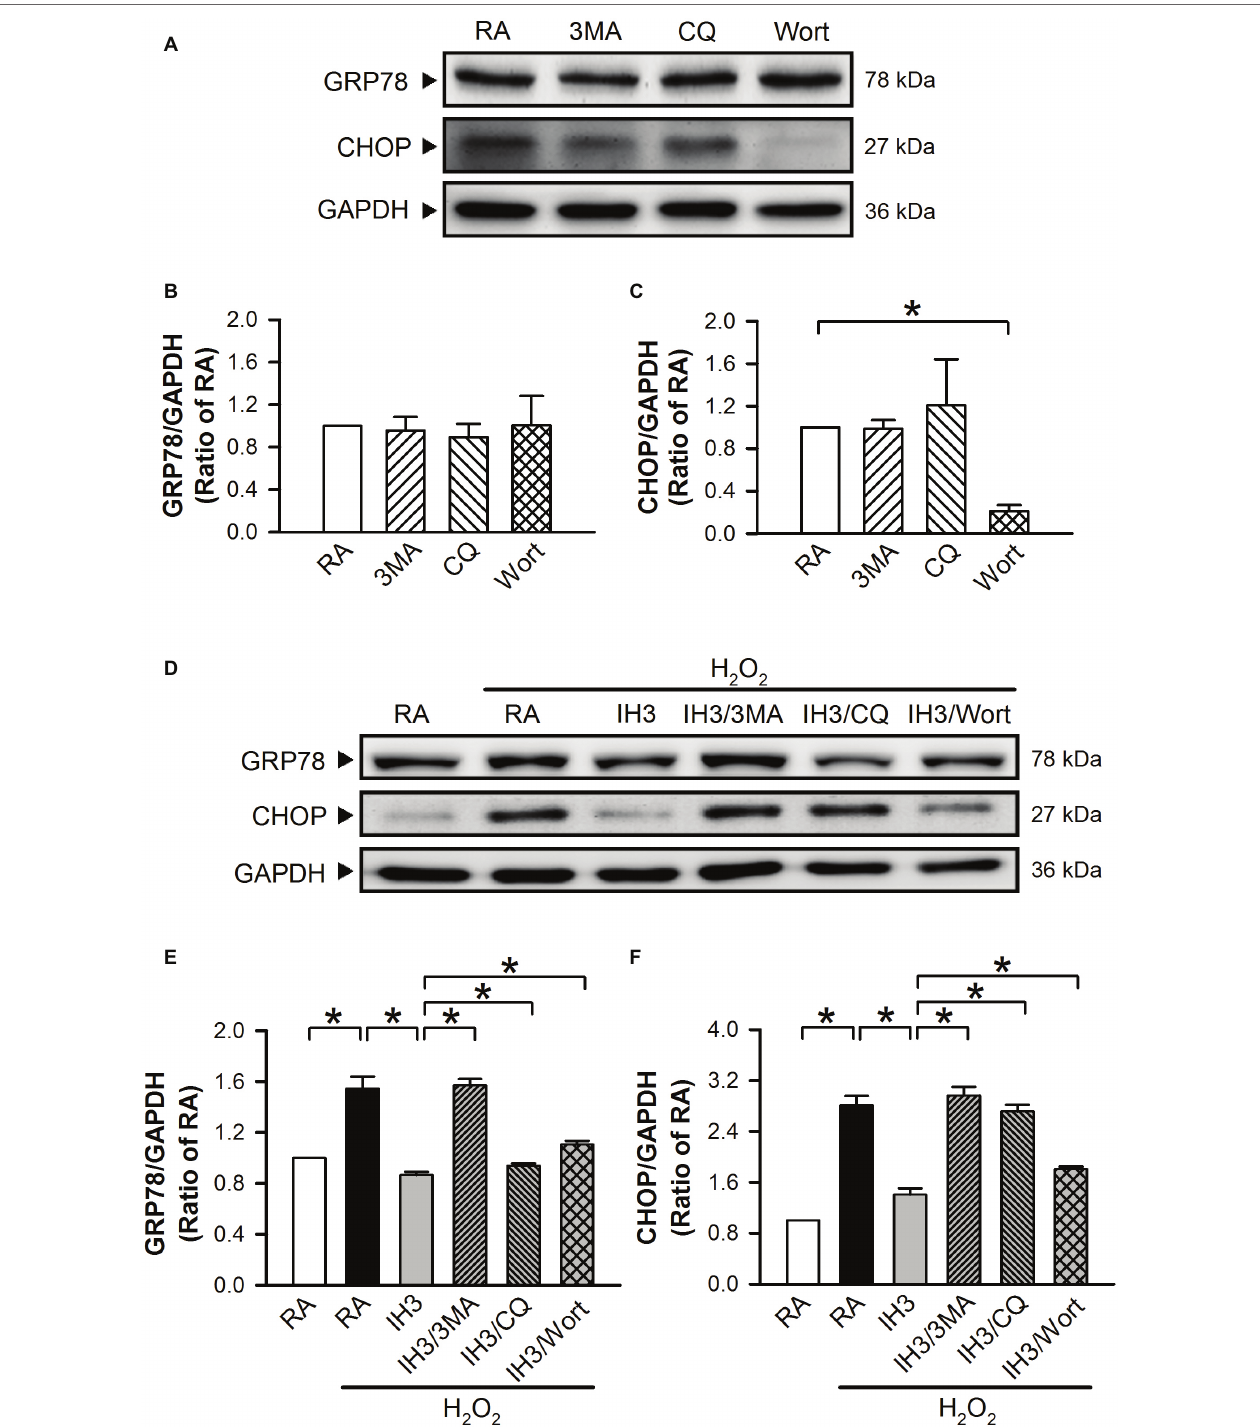
FIGURE 4 | Involvement of autophagy in the IH-reduced ER stress in H9c2 cells. (A) A representative result of GRP78, CHOP, and GAPDH protein levels determined by Western blot analyses. Quantitative results of the protein levels of GRP78 (B) and CHOP (C) were adjusted with GAPDH protein level and expressed as ratio over the RA group. ( n = 3). Cells were treated with RA, RA combined with 3MA, RA combined with CQ, or RA combined with Wort. (D) A representative result of GRP78, CHOP, and GAPDH protein levels determined by Western blot analyses. Quantitative results of the protein levels of GRP78 (E) and CHOP (F) were adjusted with GAPDH protein level and expressed as ratio over the RA control group. ( n = 4). Cells were treated with RA, IH for 3 days, IH for 3 days combined with 3-methyladenine (50 μM), RA combined with chloroquine (5 μM), or wortmannin (5 nM). Values are means ± SEMs. * p < 0.05. 3MA, 3-methyladenine; CQ, chloroquine; IH, intermittent hypoxia; RA, room air; Wort,